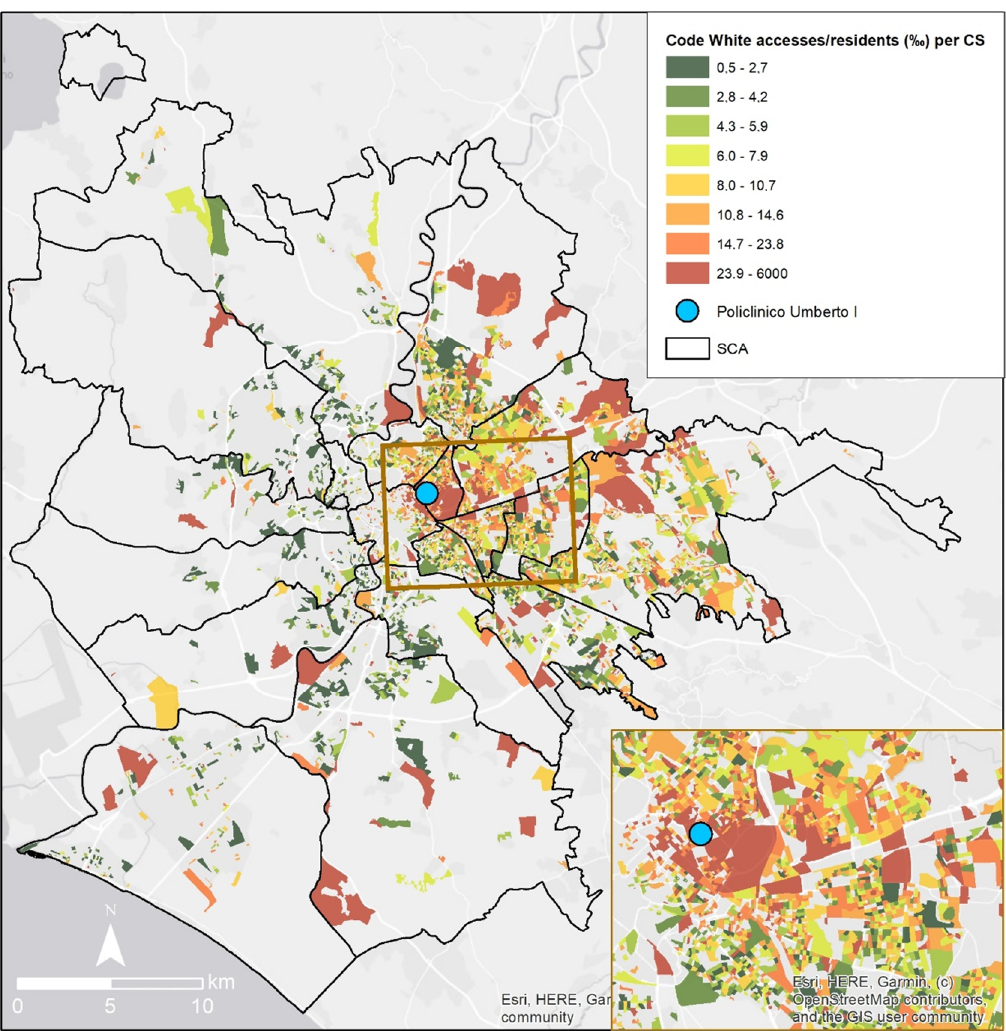
Figure 6. Accesses in code white recorded by the Policlinico Umberto I emergency room in relation to the number of residents, with data aggregated on the basis of census sections. Source: authors’ elaboration.